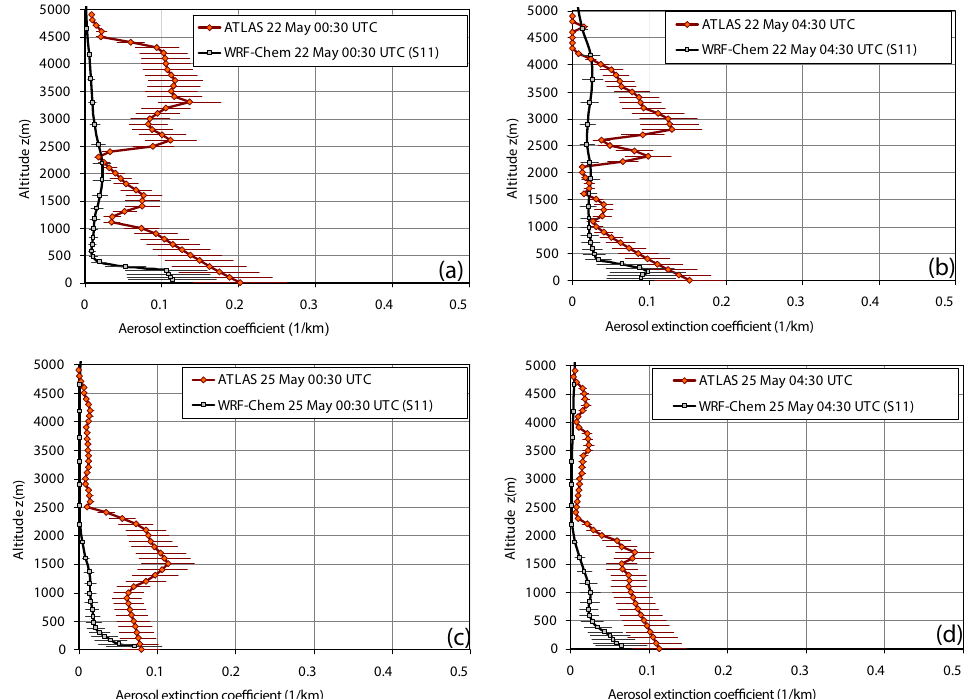
Figure A4. As in Fig. 8 except that the S11 rather than the S01 configuration is